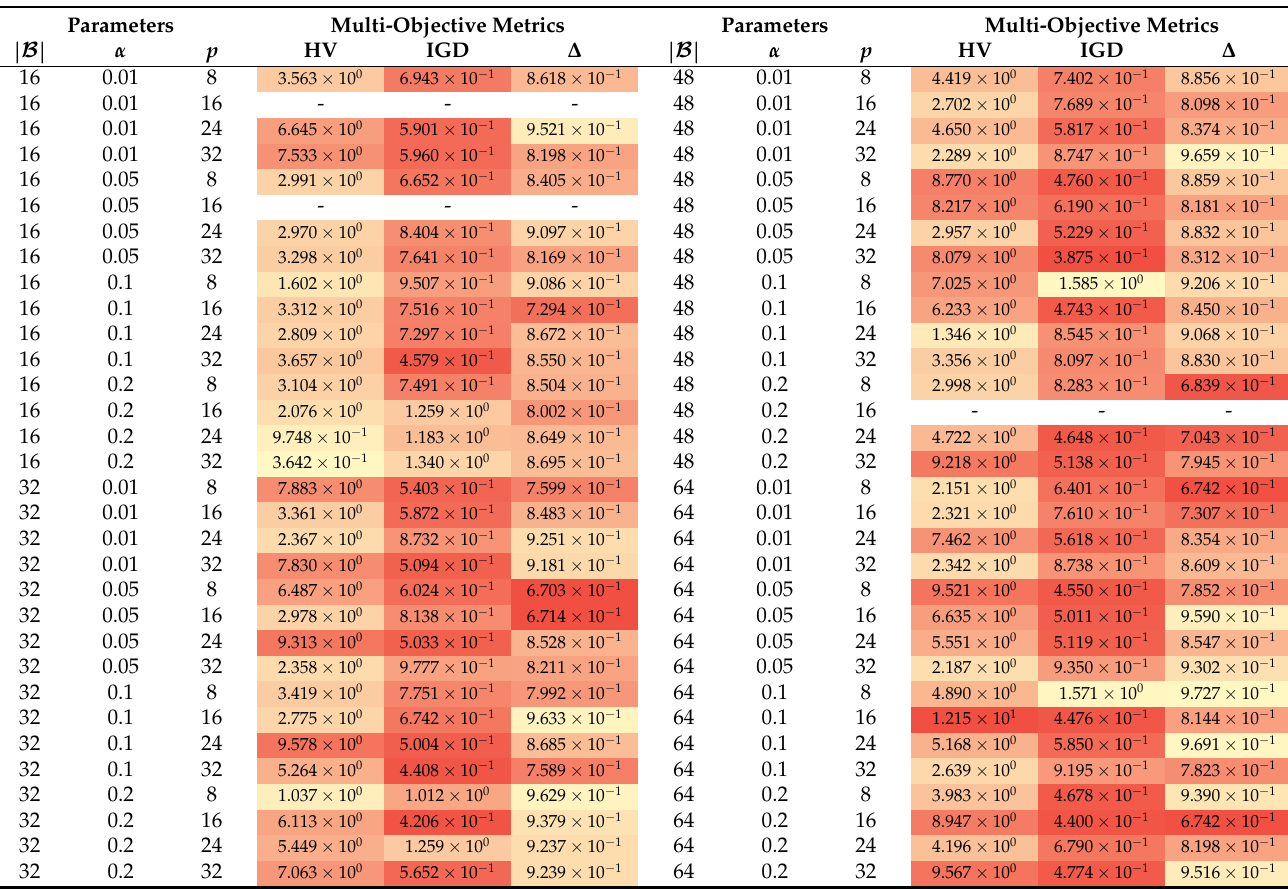
Table 2. Results of the factorial